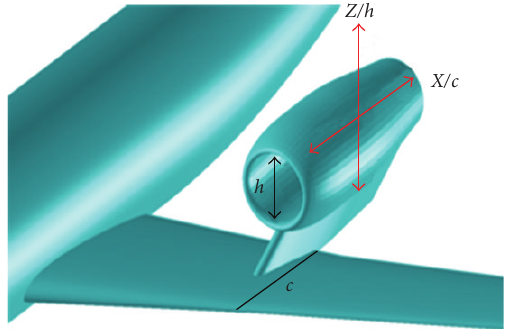
Figure 2: Definition of nacelle position.